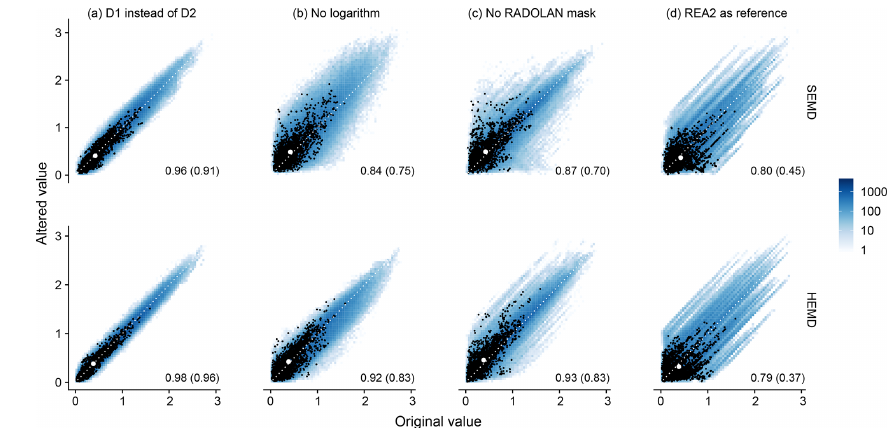
Figure 14. Bivariate histograms of the original wavelet-based scores (on the x axis) against their altered versions ( y axis), including all combinations of forecast and observation date. For (a) – (c) , RADOLAN is the reference; (d) compares scores against RADOLAN to scores against REA2. Numbers indicate the correlation over all scores, and the number in brackets is the correlation obtained for matching days only (marked by black dots). The white dot represents the mean original and altered values for matching